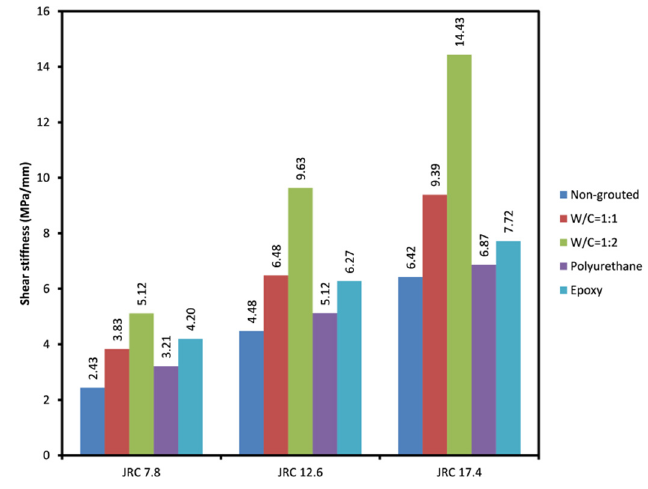
Figure 6. Average shear stiffness obtained for the rock joints tested .